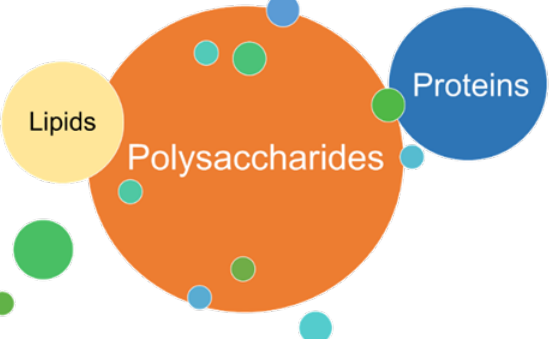
Figure 3. Major natural biological materials used in food biobased